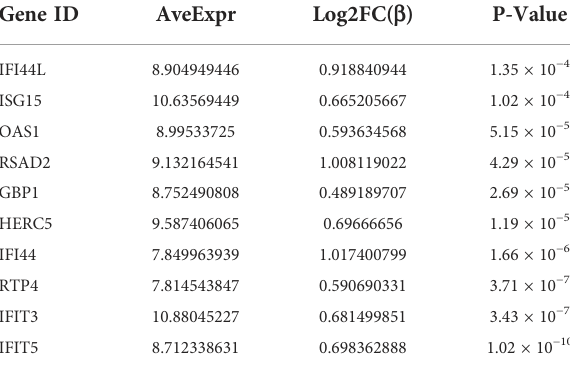
TABLE 3 Information of the top 10 hub genes in GSE93272.